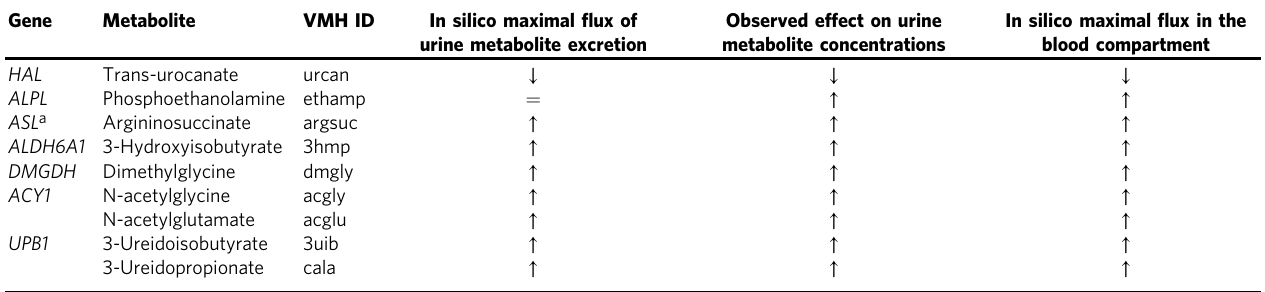
Table 4 Comparison of in silico knockout whole-body metabolic models versus healthy whole-body metabolic models using COBRA modeling with GWAS